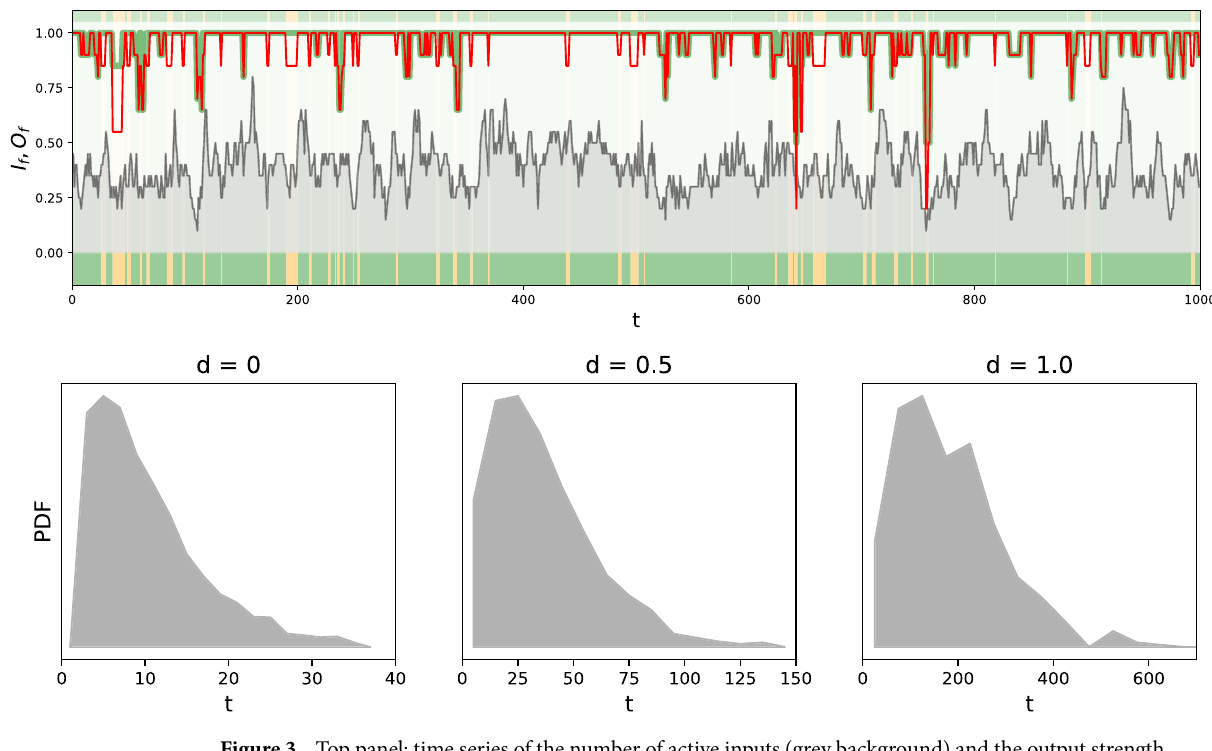
Figure 3. Top panel: time series of the number of active inputs (grey background) and the output strength for the healthy (green) and the disease (red) network. A difference between the red and the green curve (red below green) indicates visible symptoms. The type of the observed disease is indicated by the colour bar (colour code as defined in Fig. 1a). Further time series for different sets of parameters can be found in the supplement. Bottom panel: histograms of disease incidences for different values of d